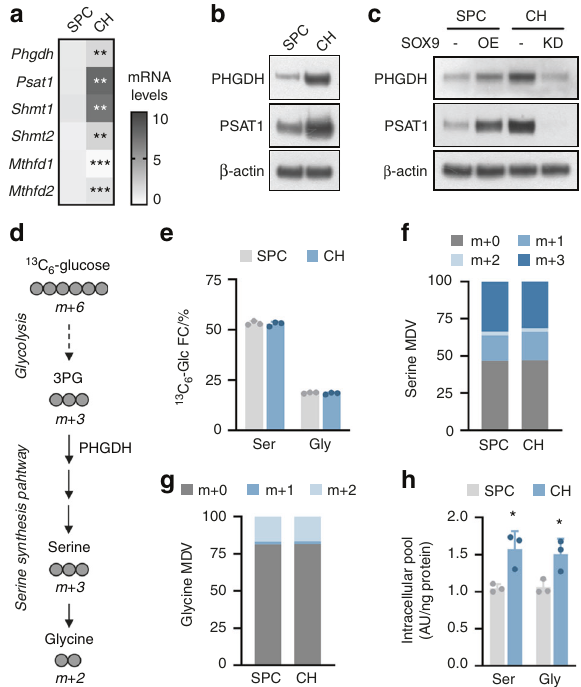
Fig. 1 The serine synthesis pathway in growth plate chondrocytes. a Phgdh , Psat1 , Shmt1 , Shmt2 , Mthfd1 , and Mthfd2 mRNA levels in cultured skeletal progenitor cells (SPCs) and growth plate chon- drocytes (CHs) ( n = 3). b Immunoblot of PHGDH, PSAT1 and β -actin in SPCs and CHs ( n = 3). c Immunoblot of PHGDH, PSAT1 and β -actin in SPCs and CHs after transduction with a lentiviral vector carrying a SOX9 overexpression (OE) plasmid or a shRNA (KD) against SOX9 ( n = 3). Empty vector or scrambled shRNA was used as the respective control. d Schematic of carbon atom (circles) transitions of 13 C 6 -glucose used to detect label incorporation into the shown metabolites. e Fractional contribution (FC) of 13 C 6 -glucose ( 13 C 6 -Glc) to serine (Ser) and glycine (Gly) in SPCs and CHs ( n = 3). Serine ( f ) and glycine ( g ) labeling from 13 C 6 -glucose in SPCs and CHs ( n = 3). Speci fi c mass distribution vectors (MDVs) for each metabolite are shown. h Intracellular Ser and Gly levels in SPCs and CHs ( n = 3). The data are presented as the means ± SDs; * P < 0.05 vs. SPCs, ** P <